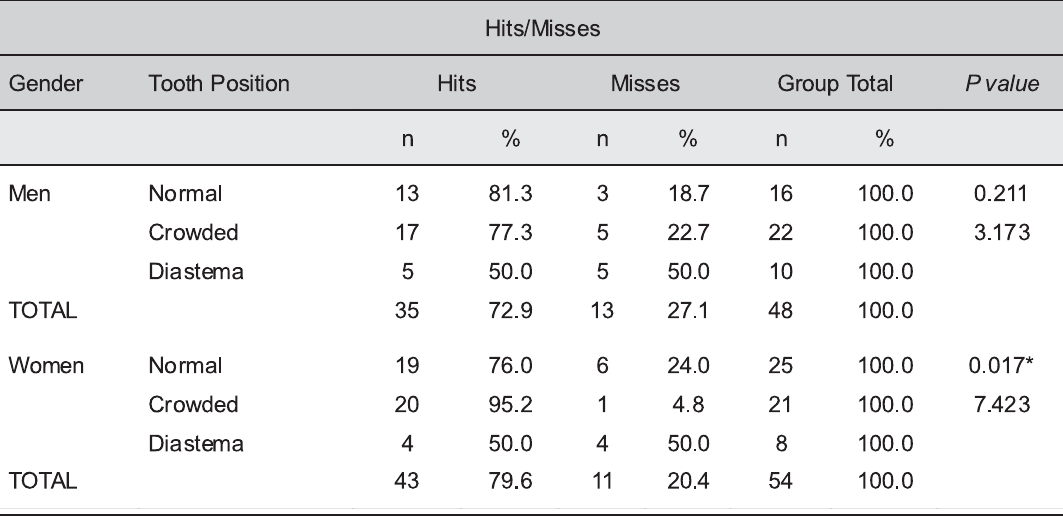
Table 1 - Distribution of hits and misses for normal tooth position, crowded teeth and teeth with